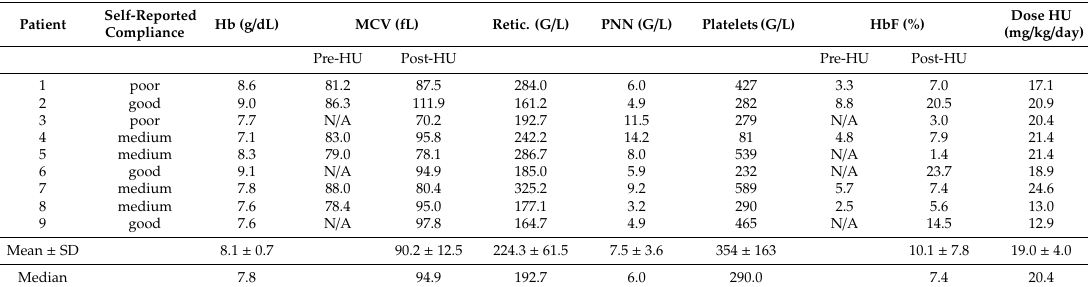
Table 2. Self-reported compliance, biological parameters, and HU intake characteristics of the nine children on HU.